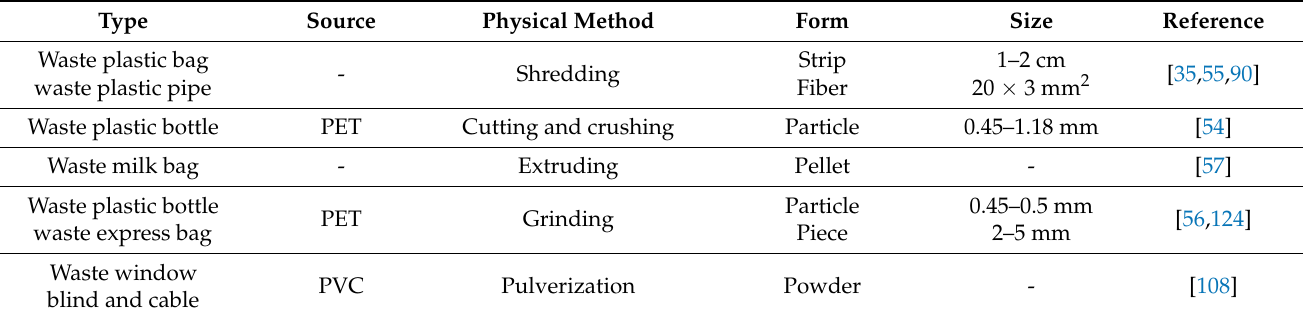
Table 6. Comparison of physical methods for pretreating waste